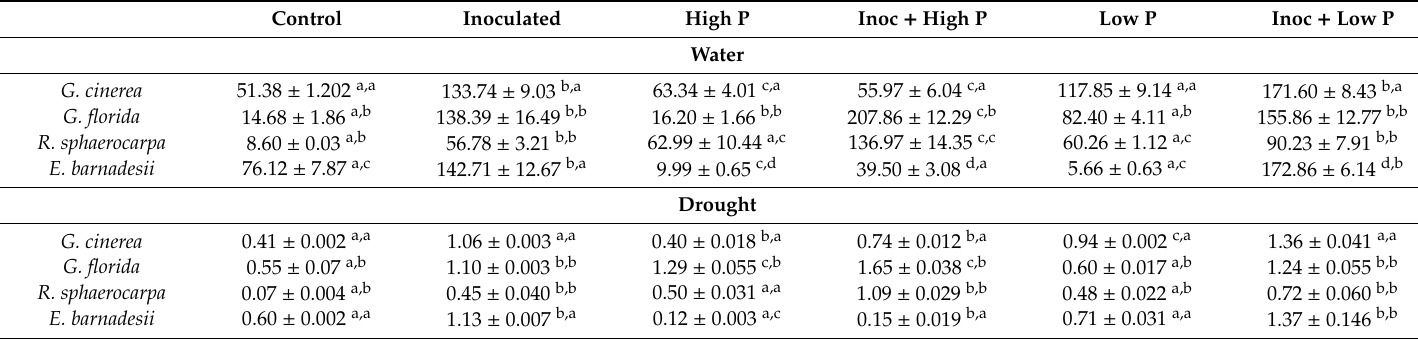
Table 1. Relative growth rates of roots of G. cinerea , G. florida , E. barnadesii and R. sphaerocarpa plants supplied with high P (500 µ M) and low P (5 µ M) phosphate grown with and without rhizobial inoculation under two water regimes (water: well irrigated and drought: water stressed). Values are presented as means ( n = 13–15) with standard deviation. The di ff erent letters indicate significant di ff erences among the treatments, where the prime lettering indicates the comparisons between the same organ ( p ≤ 0.05) and the second between plant